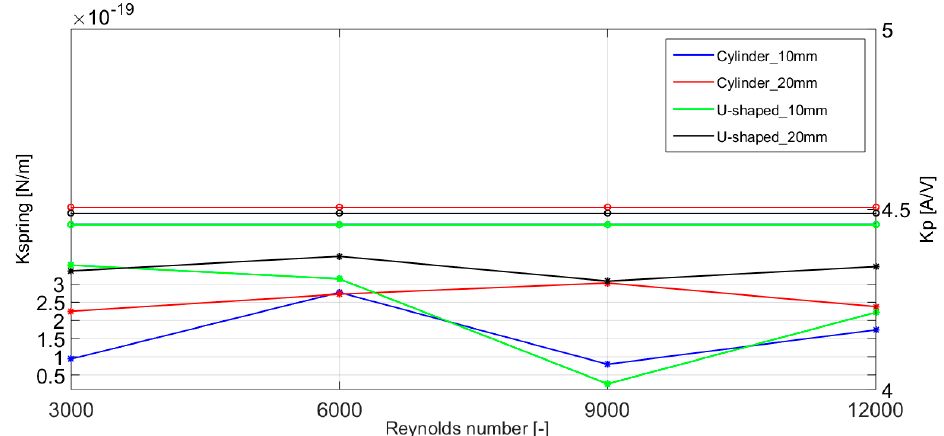
Figure 8. Comparison of the optimal values of the Kp and Kspring parameters for the proposed four di ff erent energy harvesting system geometries.